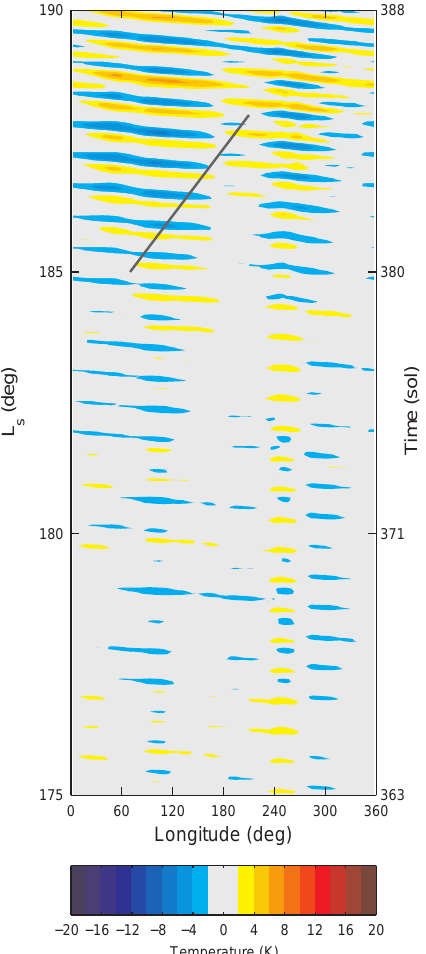
Fig. 8. As in Fig. 6 for a physical reconstruction considering transi- tional EOFs only, as listed in Table